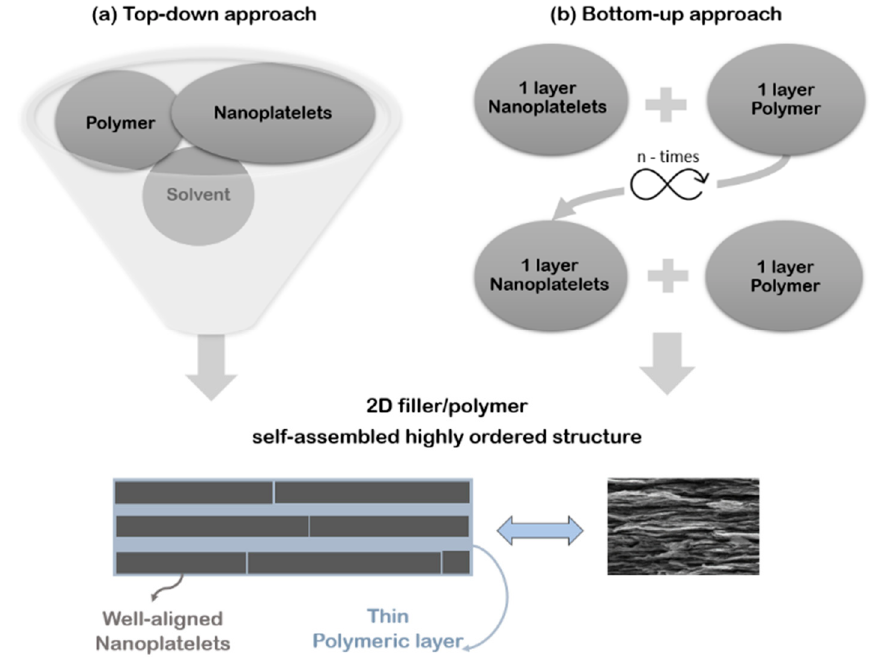
Figure 1. Top-down ( a ) and bottom-up ( b ) approaches for manufacturing of composites with B&M architecture.